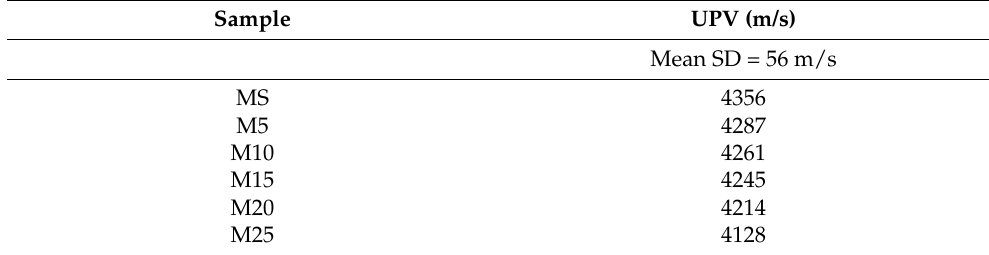
Table 6. Ultrasonic pulse velocity of the specimens MS, M5, M10, M15, M20, and M25 at 28 days of curing.